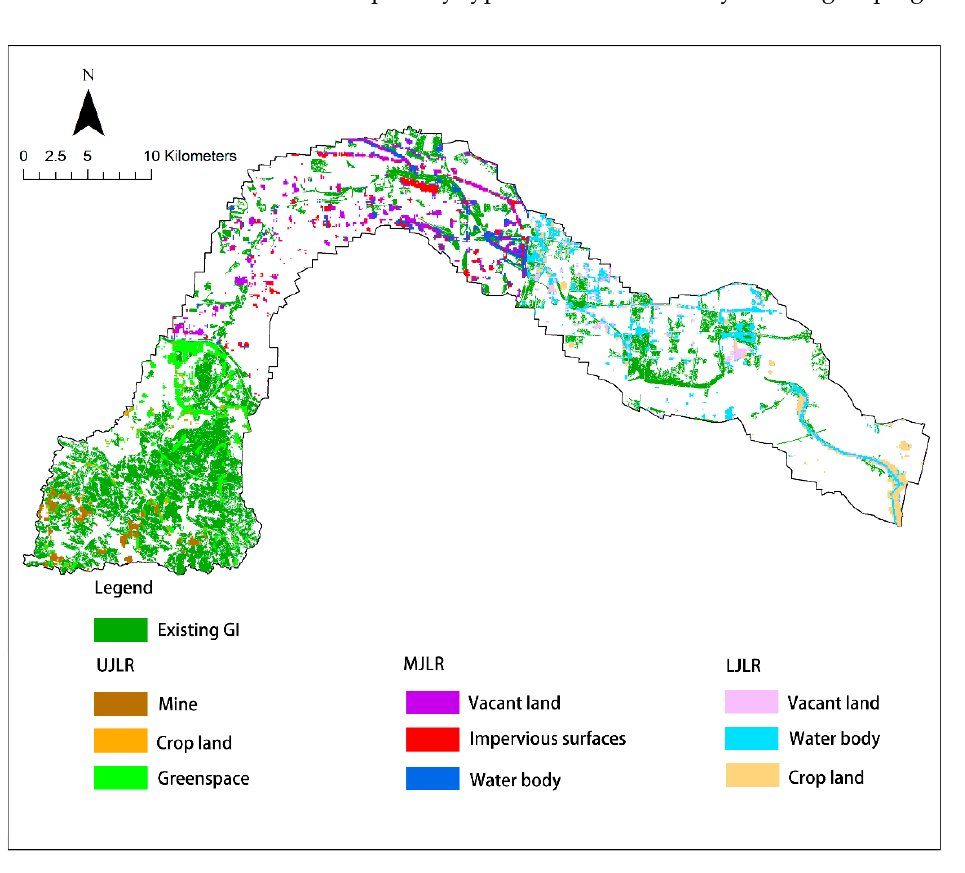
Figure 7. Cluster maps of local bivariate Moran’ I between landscape characteristics indexes of riverfront and flood inundation intensity.